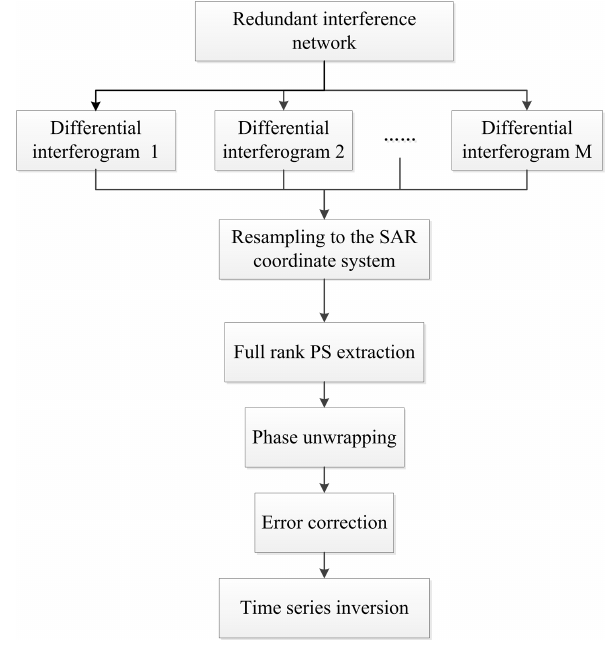
Figure 4. Process flow of the full rank matrix small baseline subset InSAR (FRAM-SBAS) time-series analysis